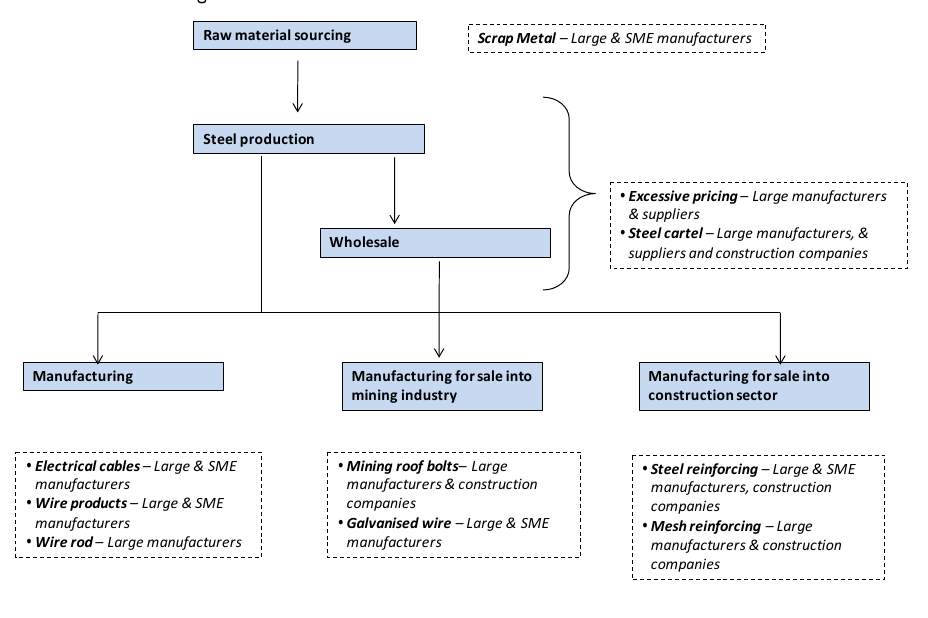
Figure 5: Cases considered in the steel value chain Source: Compiled by